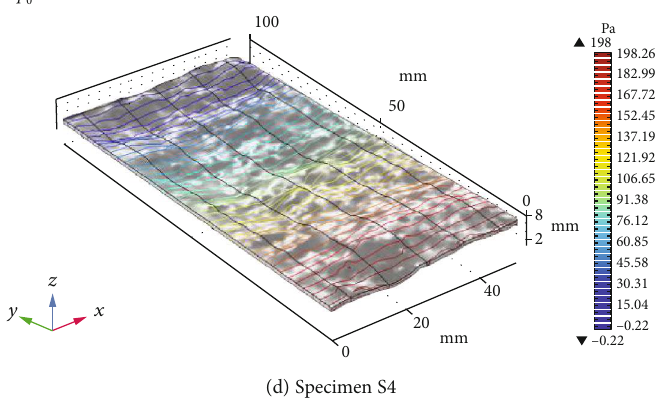
Figure 10: Comparison of surface pressure of specimens